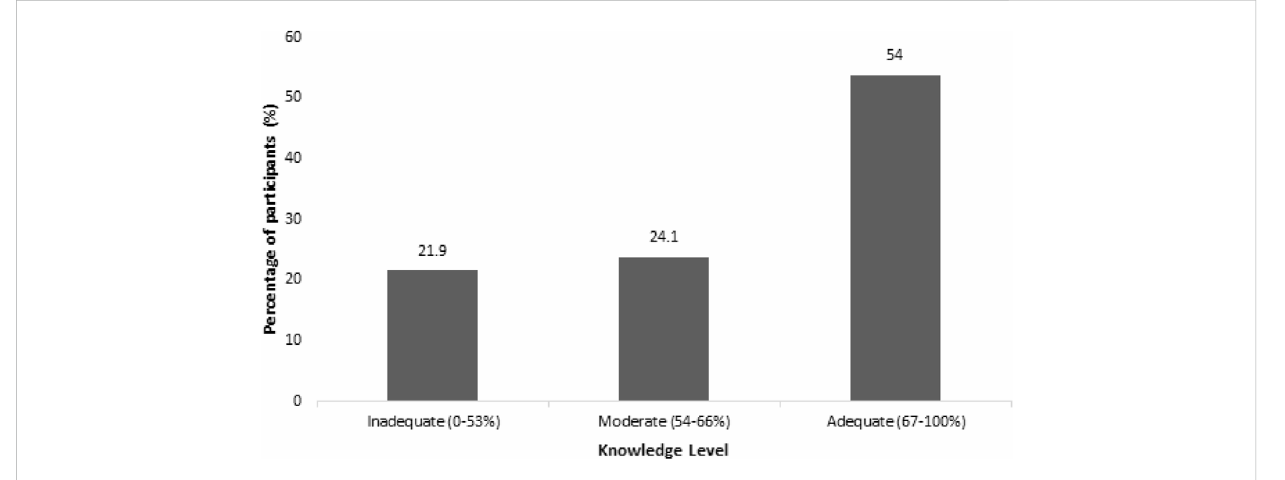
FIGURE 2 Distribution of the knowledge levels of the